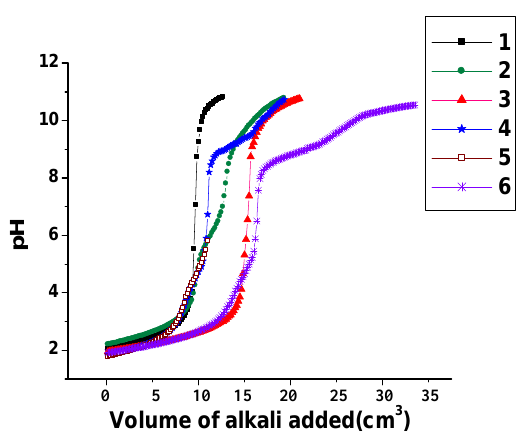
Figure 1 : Potentiometric titration curves of binary (1:1) and ternary (1:1:1) complexes of Na 2 EDTA and Vitamin B 1 ( I =0.15 M NaNO 3 at 37.0±.2 ⁰ C); 1. HNO 3 ; 2 . HNO 3 +Na 2 EDTA; 3. HNO 3 +Na 2 EDTA + Pb(NO 3 ) 2 4. HNO 3 + Vitamin B 1 ; 5. HNO